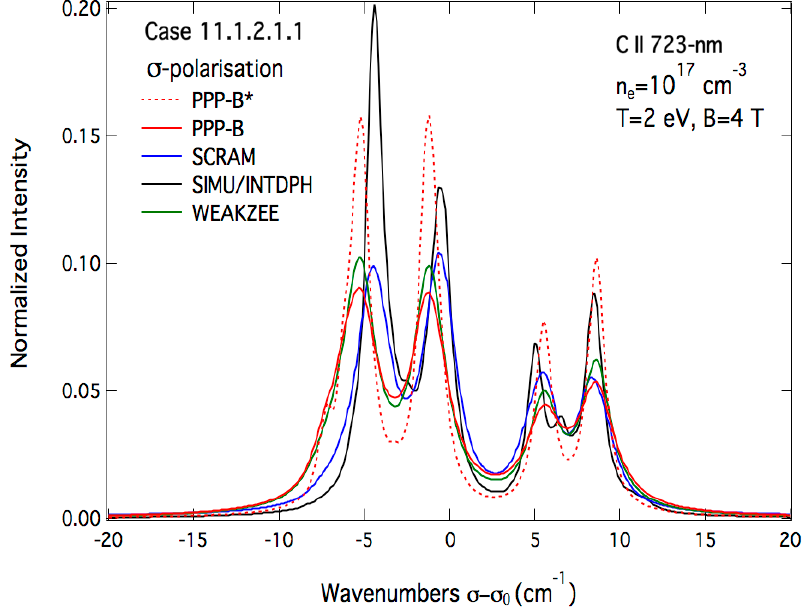
Figure 5. Comparison of the Stark–Zeeman σ -component of the C II 723-nm line as computed by the different line-shape codes for a carbon plasma with the following